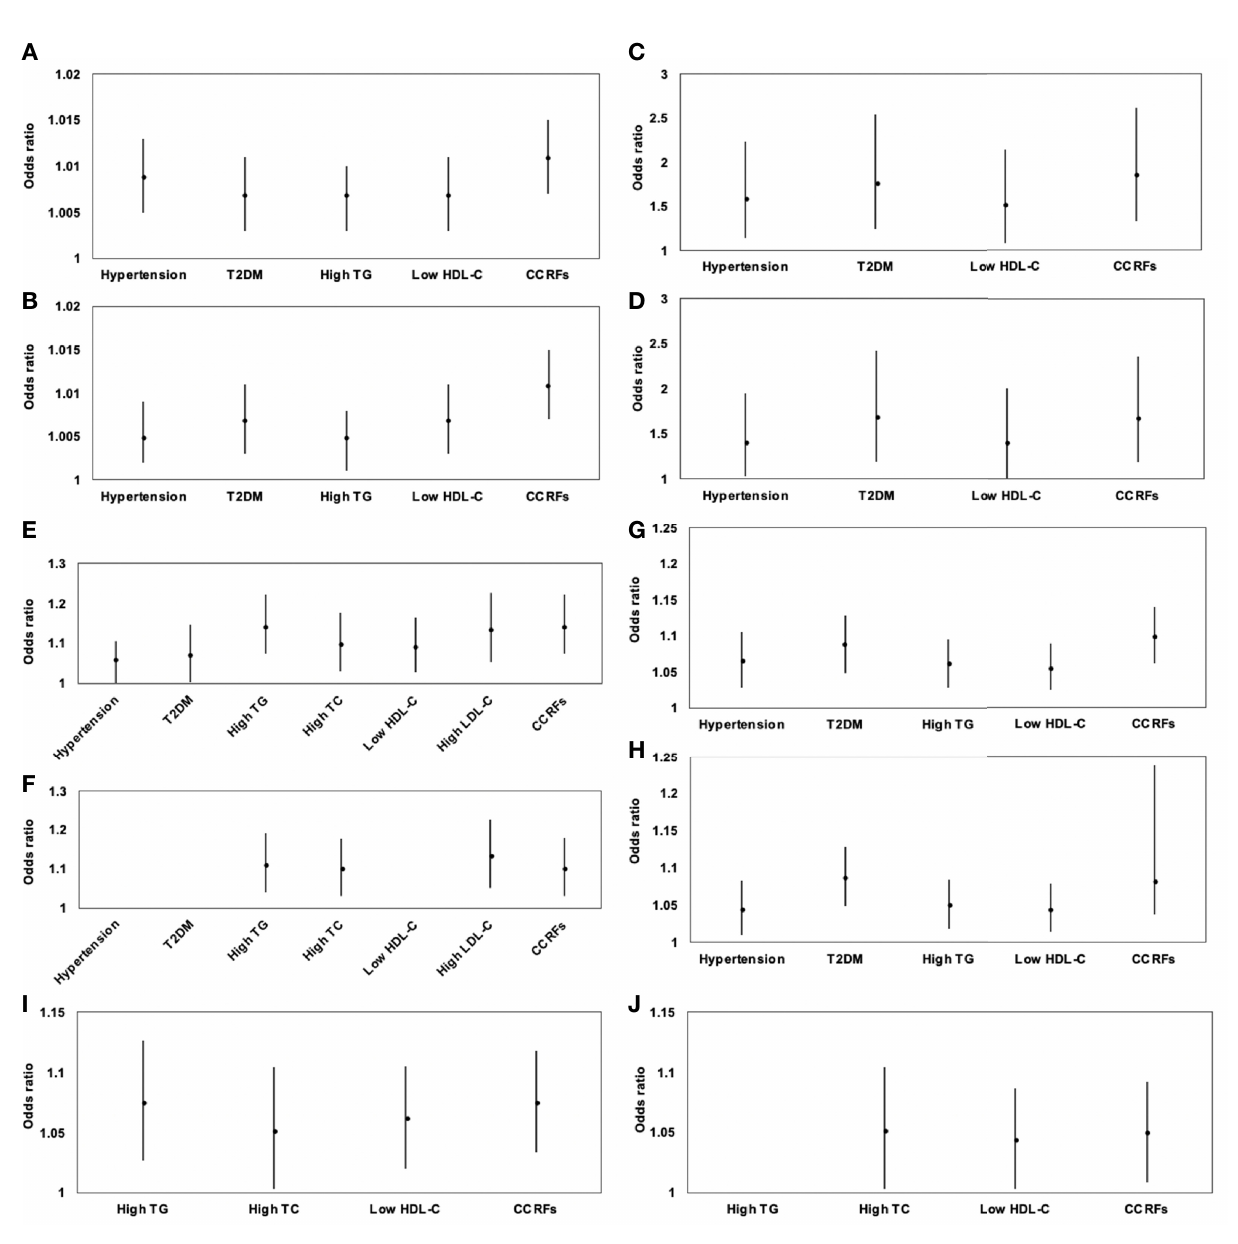
FIGURE 4 | Association of VAT area (A) , V/S (C) , hepatic FF (E) , pancreatic FF (G) , and pPAT FF (I) with dichotomous cardiometabolic risk factors and further adjustment for BMI (B , D , F , H , J) expressed by odds ratios and 95% con fi dence intervals. VAT area was signi fi cantly associated with increased risk of hypertension, T2DM, high TG, low HDL-C, and CCRFs (A) ; after further adjustment for BMI, these correlations continued to be signi fi cant (B) . V/S was signi fi cantly associated with increased risk of hypertension, T2DM, low HDL-C, and CCRFs (C) . After further adjustment for BMI, these correlations continued to be signi fi cant (D) . Hepatic FF was signi fi cantly associated with increased risk of hypertension, T2DM, high TG, high TC, low HDL-C, high LDL-C, and CCRFs (E) ; after further adjustment for BMI, these correlations continued to be signi fi cant, except for hypertension, T2DM, and low HDL-C (F) . Pancreatic FF was signi fi cantly associated with increased risk of hypertension, T2DM, high TG, low HDL-C, and CCRFs (G) ; after further adjustment for BMI, these correlations continued to be signi fi cant (H) . pPAT FF was signi fi cantly associated with increased risk of high TG, high TC, low HDL-C, and CCRFs (I) ; after further adjustment for BMI, these correlations continued to be signi fi cant, except for high TG (J)